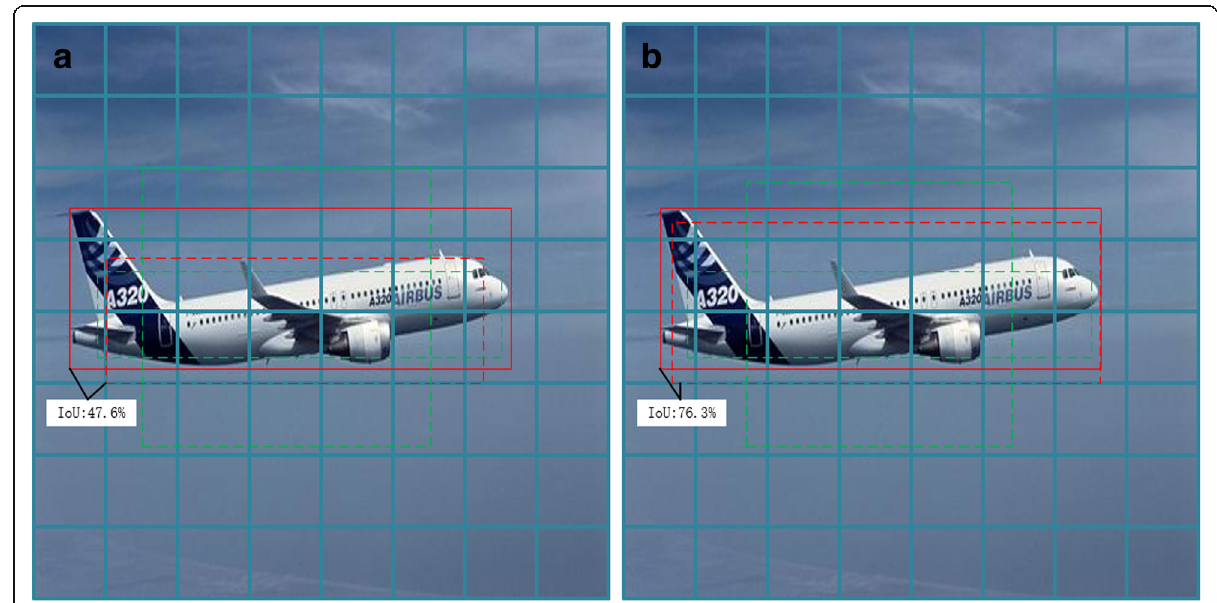
Fig. 3 Primary diagnosis unit for bounding box detection. Figure 3 shows the process by which the primary diagnostic unit detects suspicious areas containing disease and pests in the input image. It is similar to Fuentes et al. (2017b). Compared the manual setting of boundary boxes with the k-means++ clustering generation of boundary boxes, in which the red solid border is the correct border and the red dotted border is the highest border in IoU of different methods of generating boundary boxes. a The size and shape of the default boundary box set manually are usually not able to obtain high IoU, and b the prior knowledge of the boundary box is obtained from tens of millions of samples using k-means++ (thin, high borders account for the